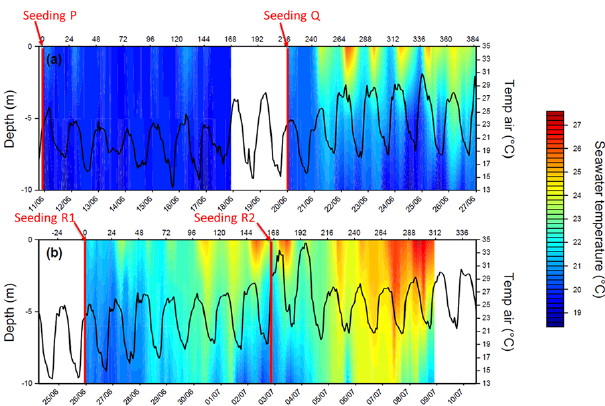
Fig. 9a. Temperature profiles inside the mesocosms during the three DUNE experiments. Air temperatures are superimposed (black line).